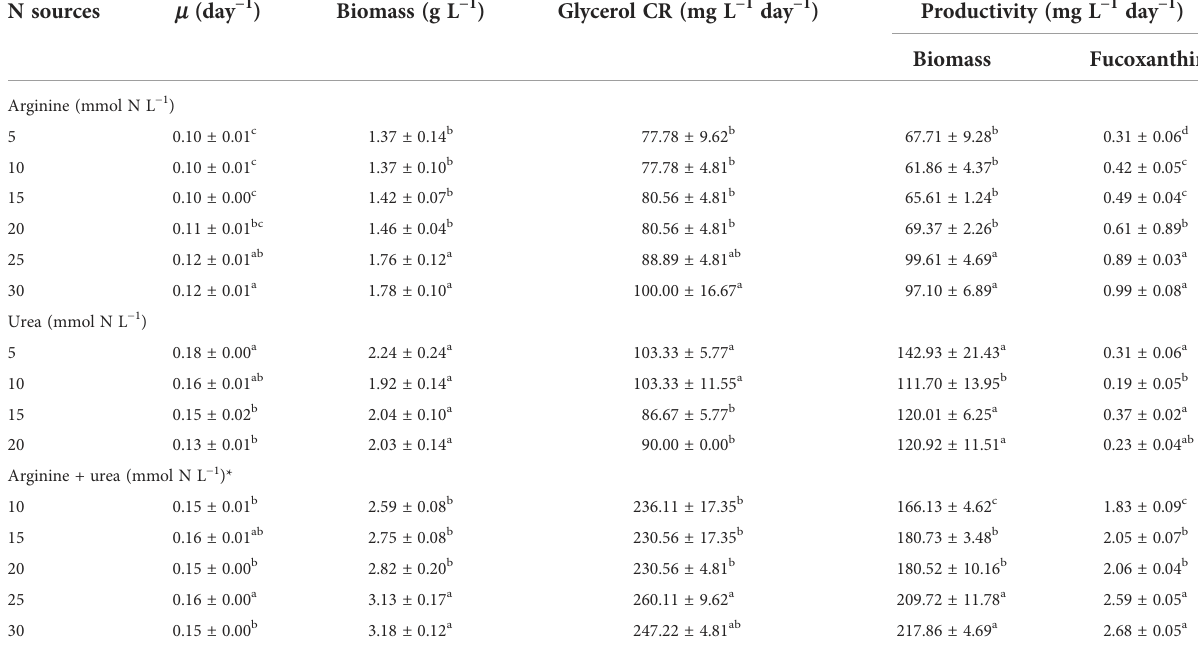
TABLE 2 The speci fi c growth rate, biomass concentration, glycerol consumption rate (CR), and productivities of biomass and fucoxanthin in the mixotrophic growth of Phaeodactylum tricornutum using different types and concentrations of nitrogen sources in shaking fl asks. N